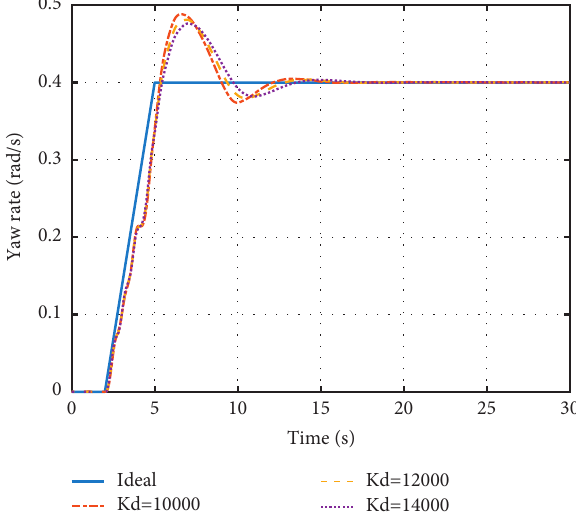
Figure 12: Yaw rate variation with different K p .